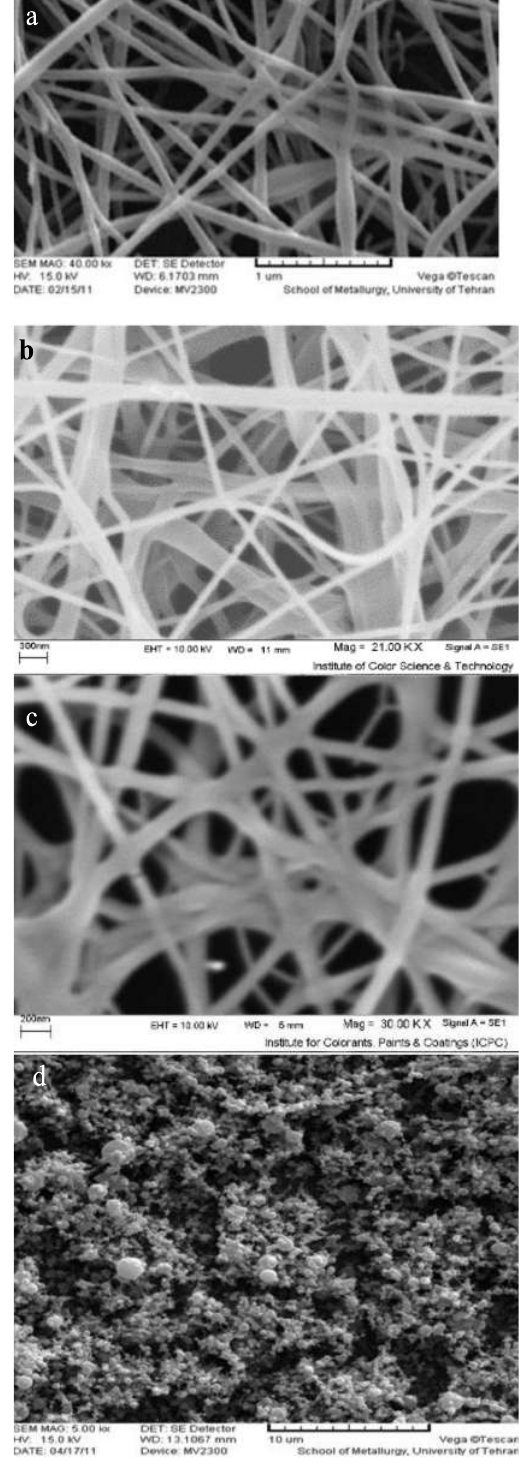
Fig. 7. SEM image of chitosan/PEO with a)0.5, b)1, c)2 and d)3 wt% cefazolin nanofibers after immersion in